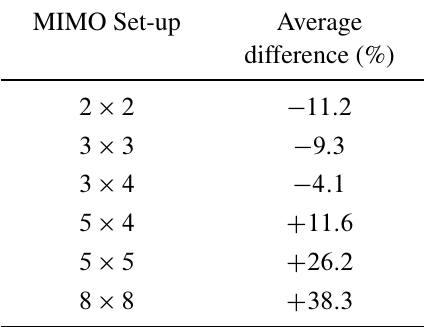
fuzzy-based approach clearly shows improvement in the values obtained for both 2 (cid:2) 2 and 4 (cid:2) 4